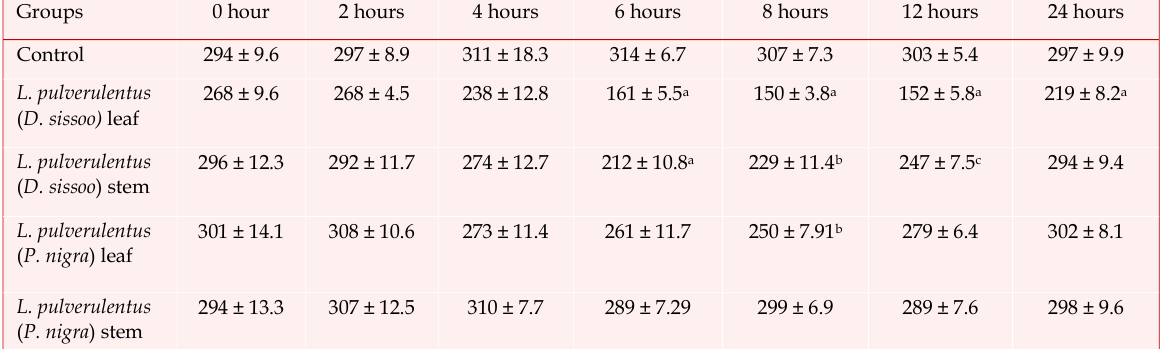
Effect of methanolic extracts of L. pulverulentus ( D. sissoo and P. nigra) in diabetic mice Groups